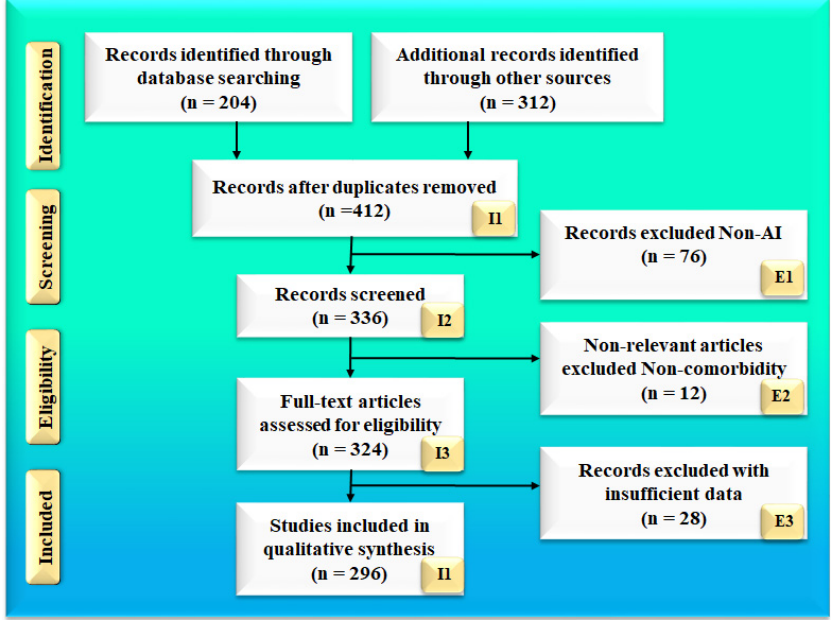
Figure 1. Research article search strategy; I: included, E: excluded, n: number of studies.